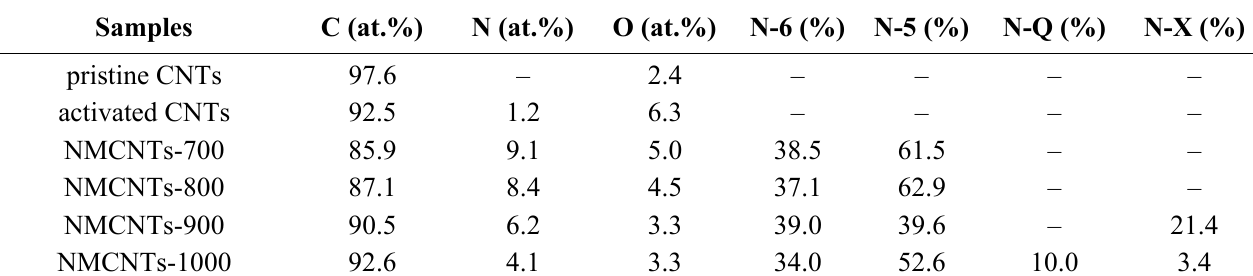
Table 2. Carbon, nitrogen and oxygen contents, and relative surface concentrations of nitrogen species obtained by fitting the N1s core level X-ray photoelectron spectroscopy (XPS)